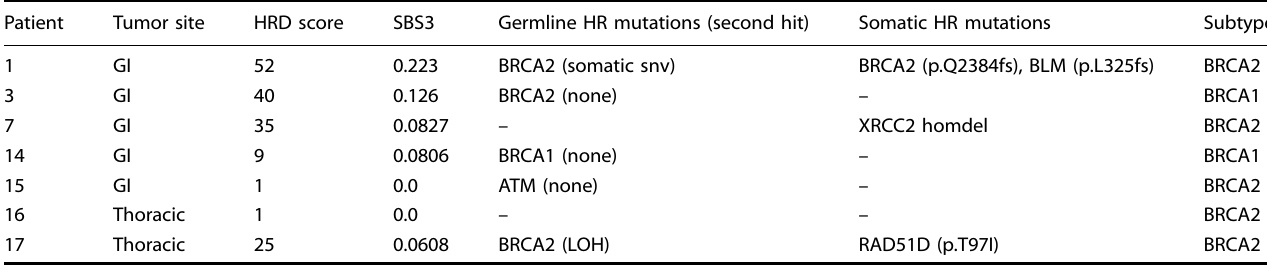
Table 4. HR mutations among patients with HRD as identi fi ed by